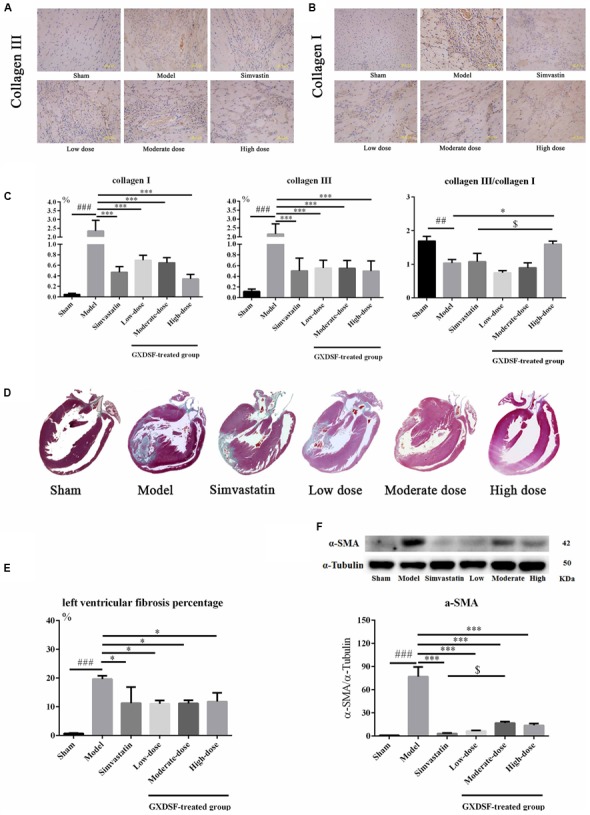
Myocardial fibrosis in MIRI-LVR rats treated with different doses of GXDSF. The immunohistological localization of collagen III (A) and collagen I (B) is shown. Bars represent 50 μm. The relative expression of collagen I and III and the relative ratio of collagen III/I (C) are shown in bar graphs. Masson’s trichrome staining (D) and the percentage of left ventricular fibrosis area (E) are provided. A gel image with an internal reference (α–tubulin) and the relative expression of α–SMA (F; column graph) are shown. Compared with the sham group: ##P < 0.01, ###P < 0.001. Compared with the MIRI-LVR model group: ∗P < 0.05, ∗∗∗P < 0.001. Compared with the simvastatin group: $P < 0.05. The data are presented as the mean ± SD (n = 4 in each group).